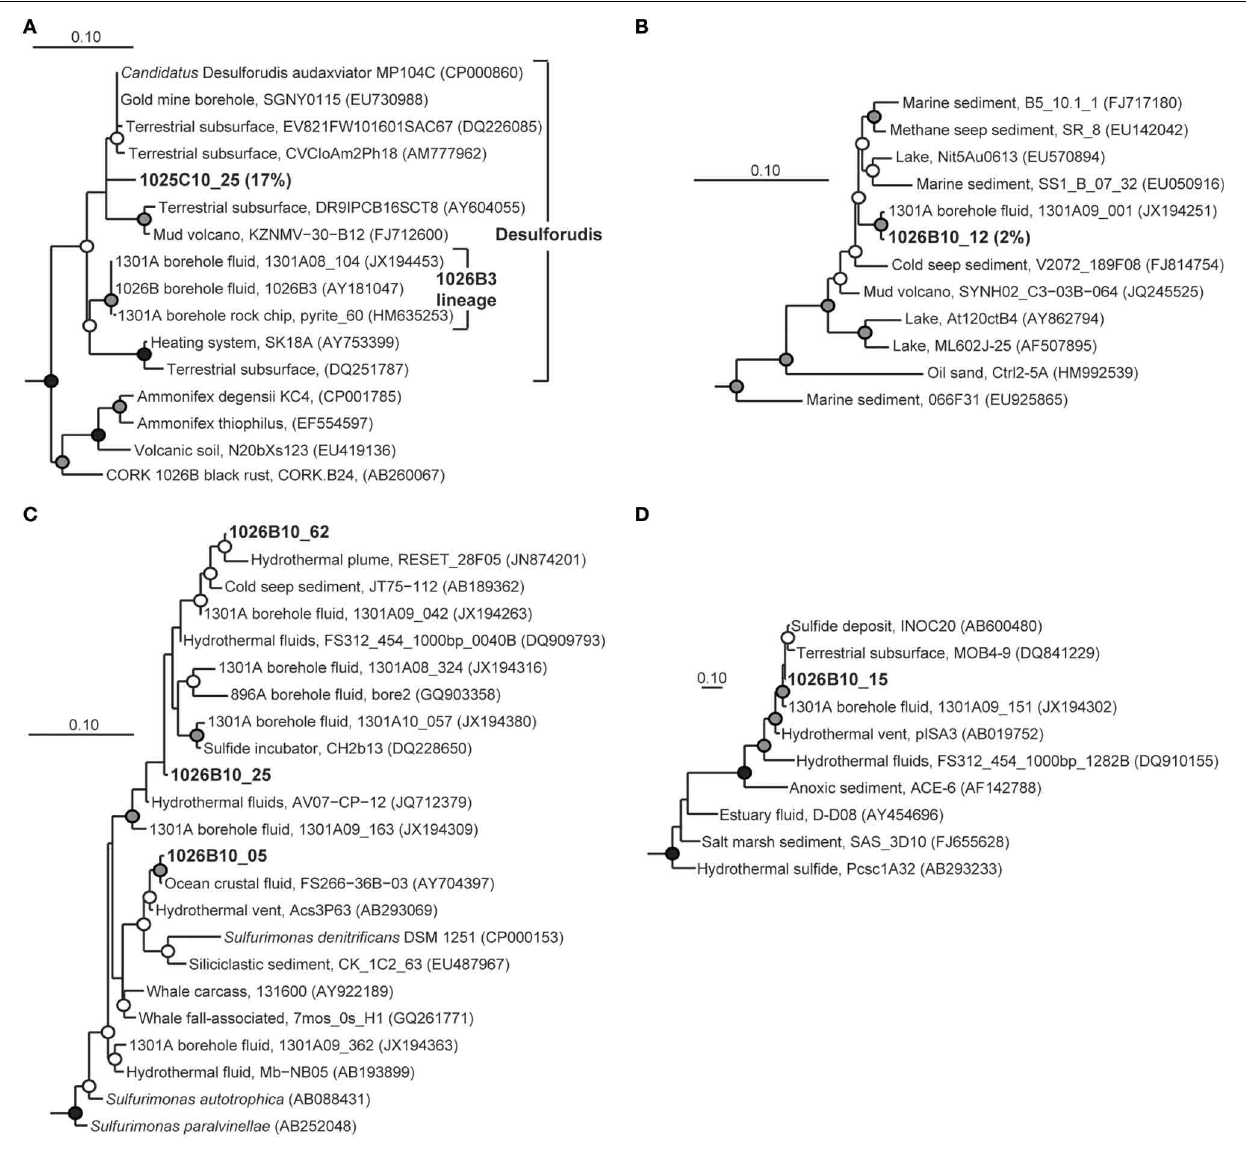
domain Archaea . Short length gene clone pyrite_60 was added to the Candidatus Desulforudis audaxviator tree after tree construction and bootstrapping and is indicated by a dashed line. Other information as in Figure 3